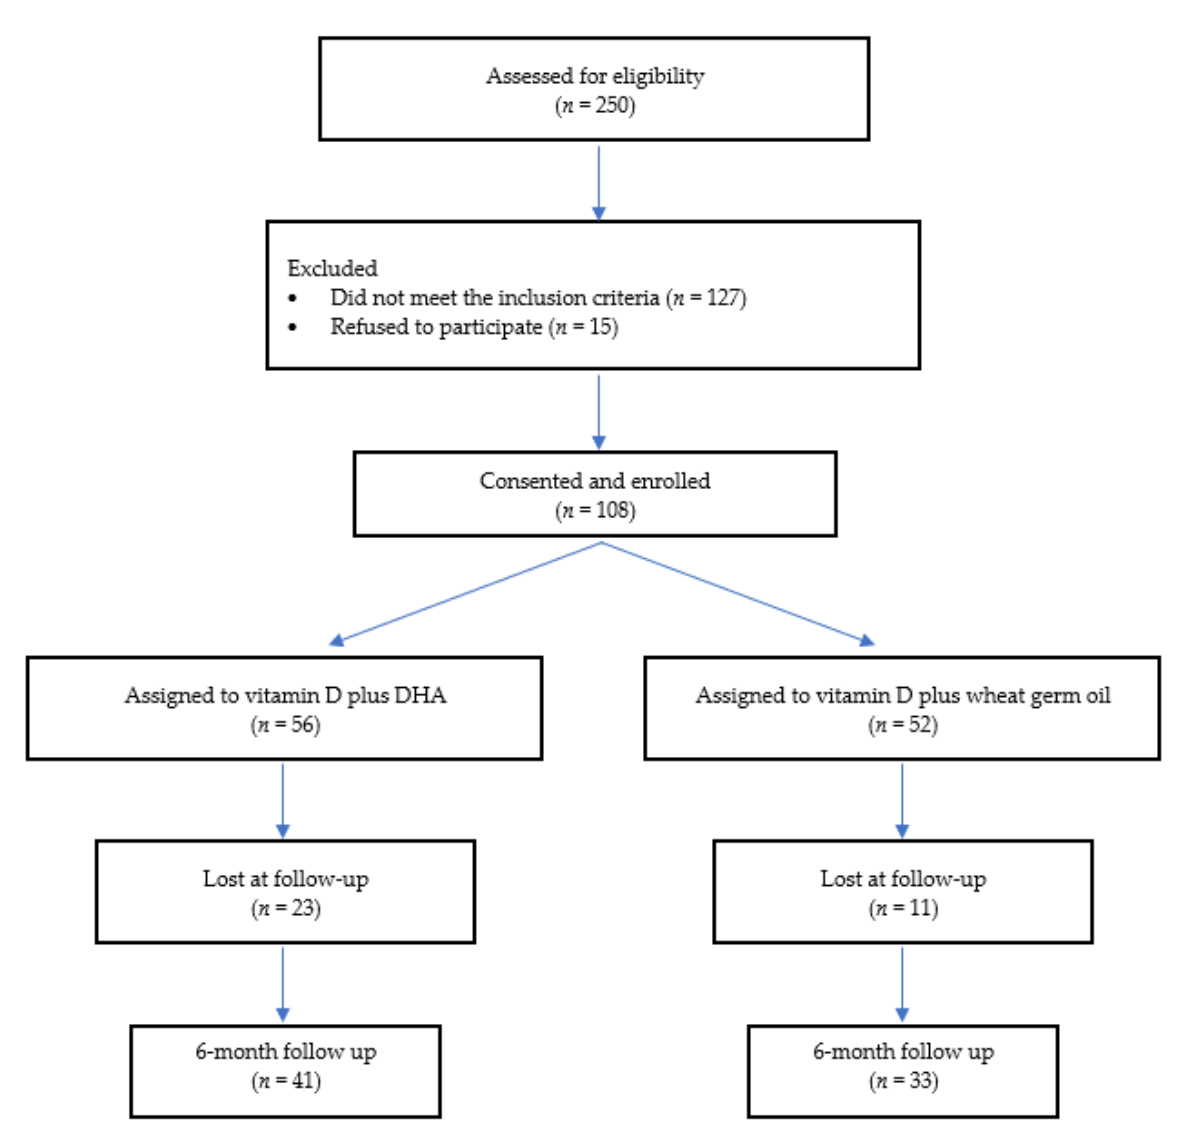
Figure 1. Enrollment flow chart. Table 1. Clinical and anthropometric variables in D + DHA group and vitamin D group after 6 months from the start of the study. Data are expressed as median (IQR).